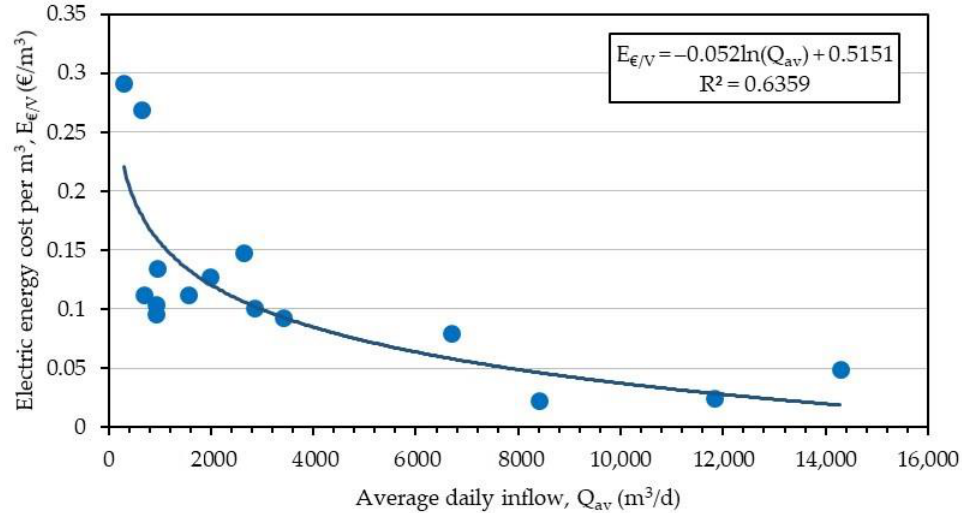
Figure 7. Blue points: electric energy cost E € / V ( € / m 3 ) per unit volume of treated wastewater, as a function of average daily wastewater flow, Q av (m 3 / d), for the 16 examined WWTPs (the WWTP in Karditsa has been exempted); blue line: trend line E € / V = − 0.052 ln (Q av ) + 0.5151 with R 2 = 0.6359.